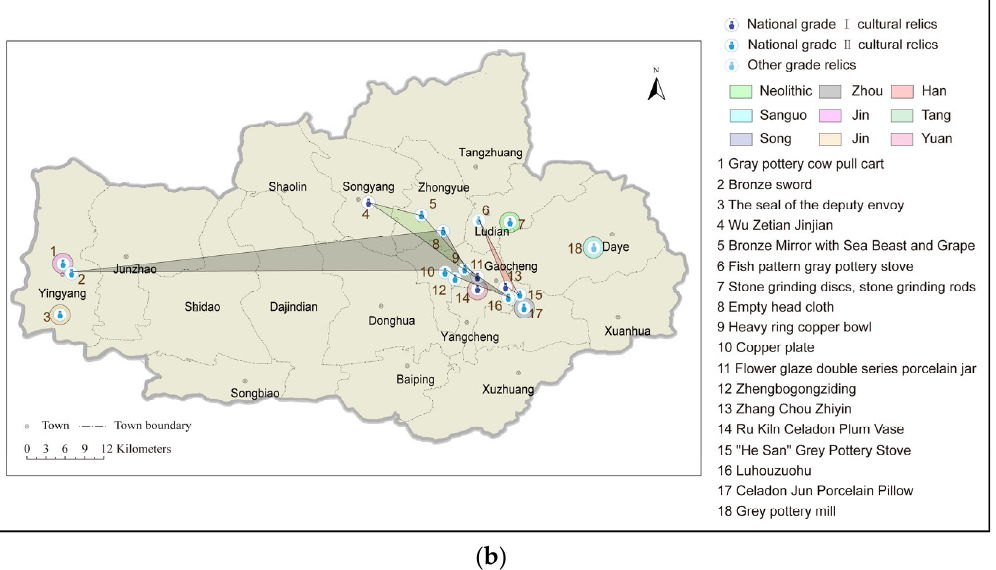
Figure 11. Graphs of the results of the spatial and temporal analysis: ( a ) spatial share of famous buildings over time; ( b ) spatial share of famous products over time.